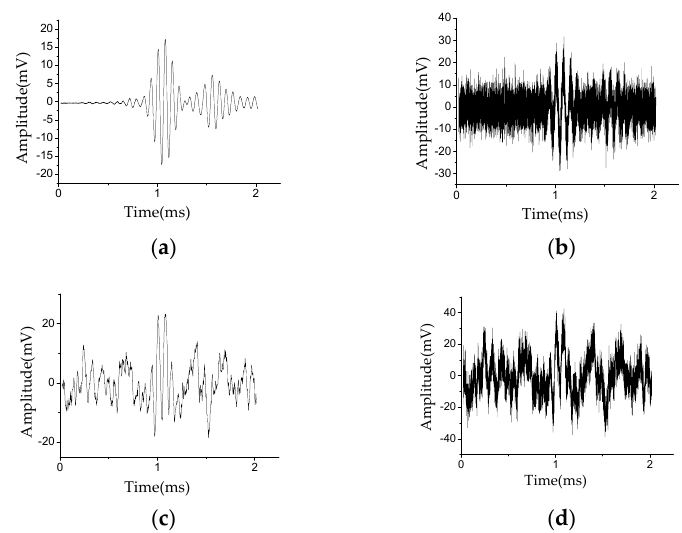
Figure 8. Waveforms of Lamb wave damage signal D(t): ( a ) pure damage signal; ( b ) damage signal with white noise; ( c ) damage signal with environment noise; ( d ) damage signal with mixed noise.